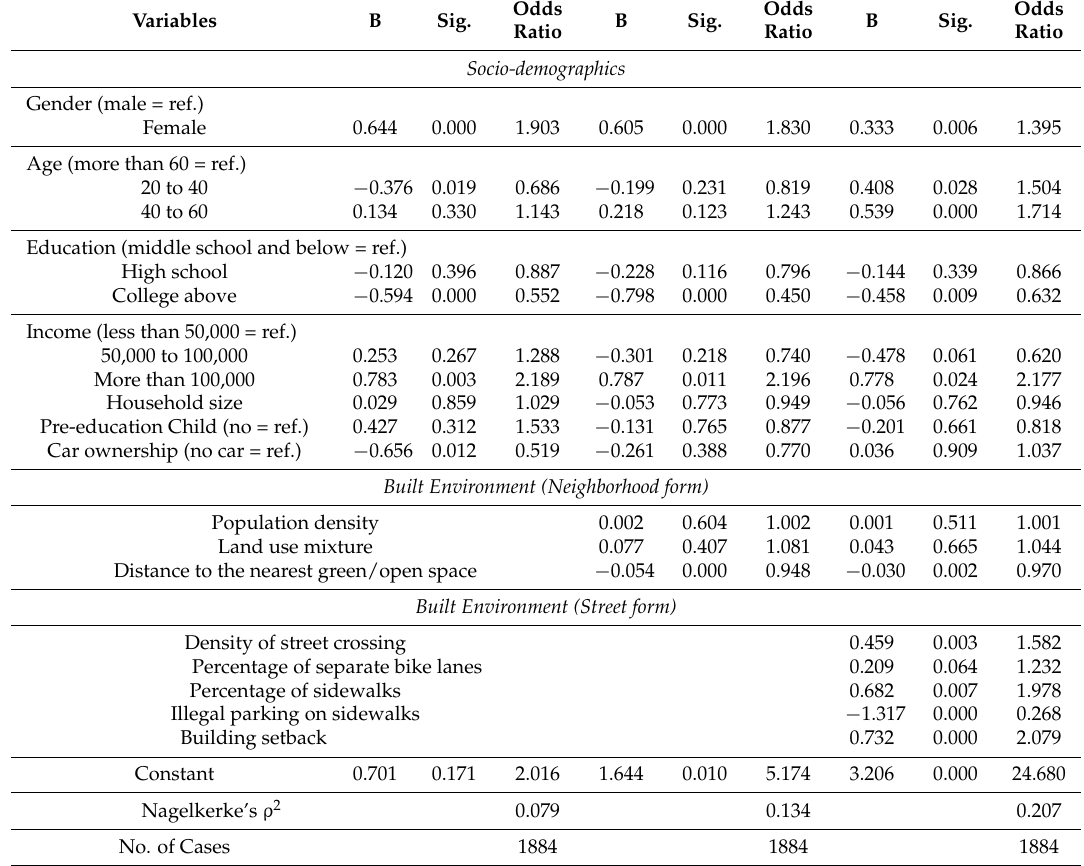
Table 5. Binary logistic model for maintenance